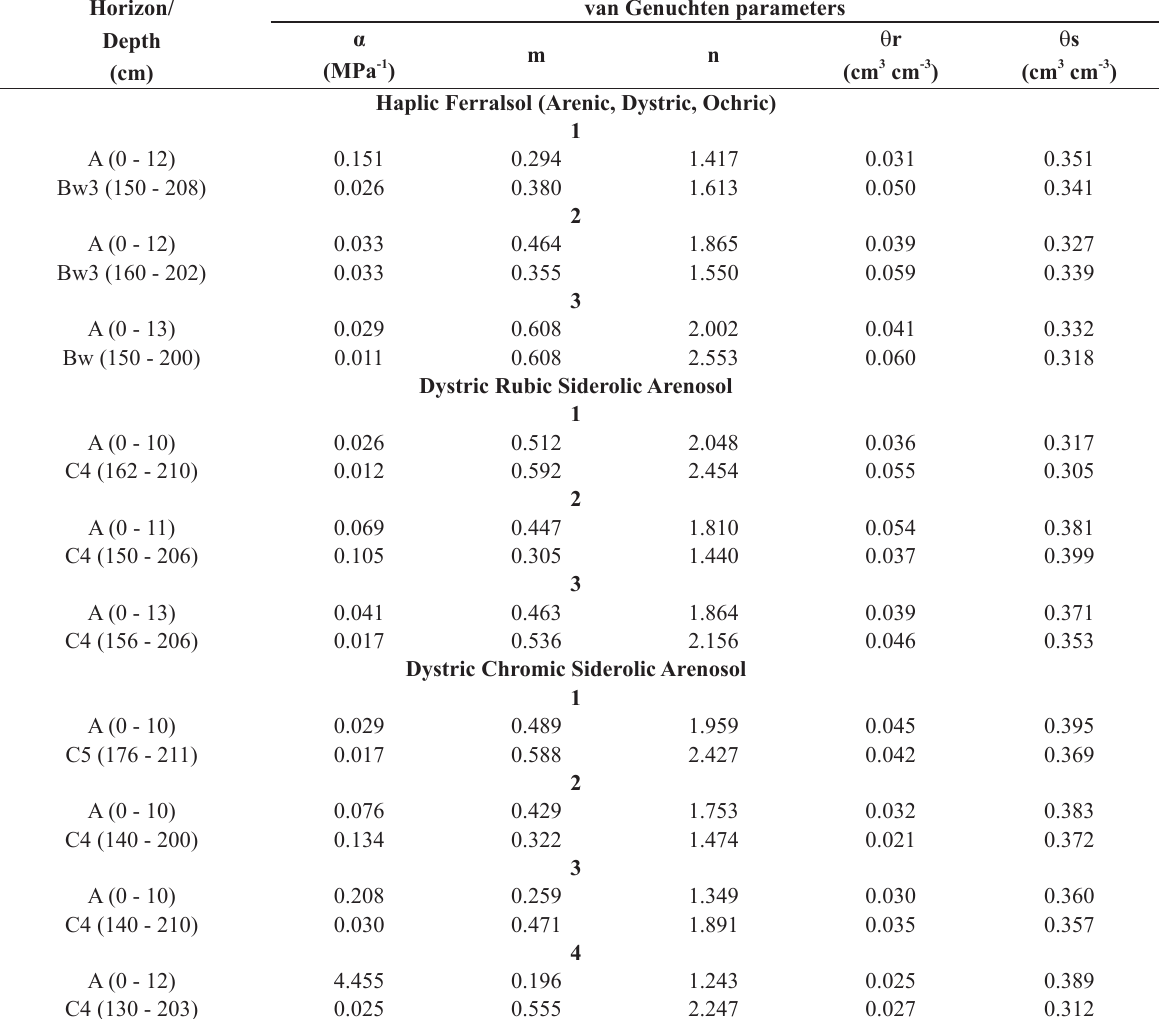
Parameters of the van Genuchten Equation 1 for horizons of sandy soil profiles from the municipality of Glória, Bahia state, Brazil, by the method of Richards’